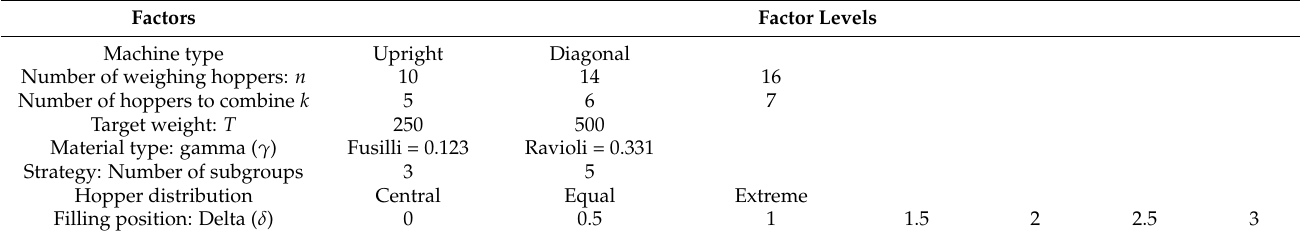
Table 7. Experiment design factors and